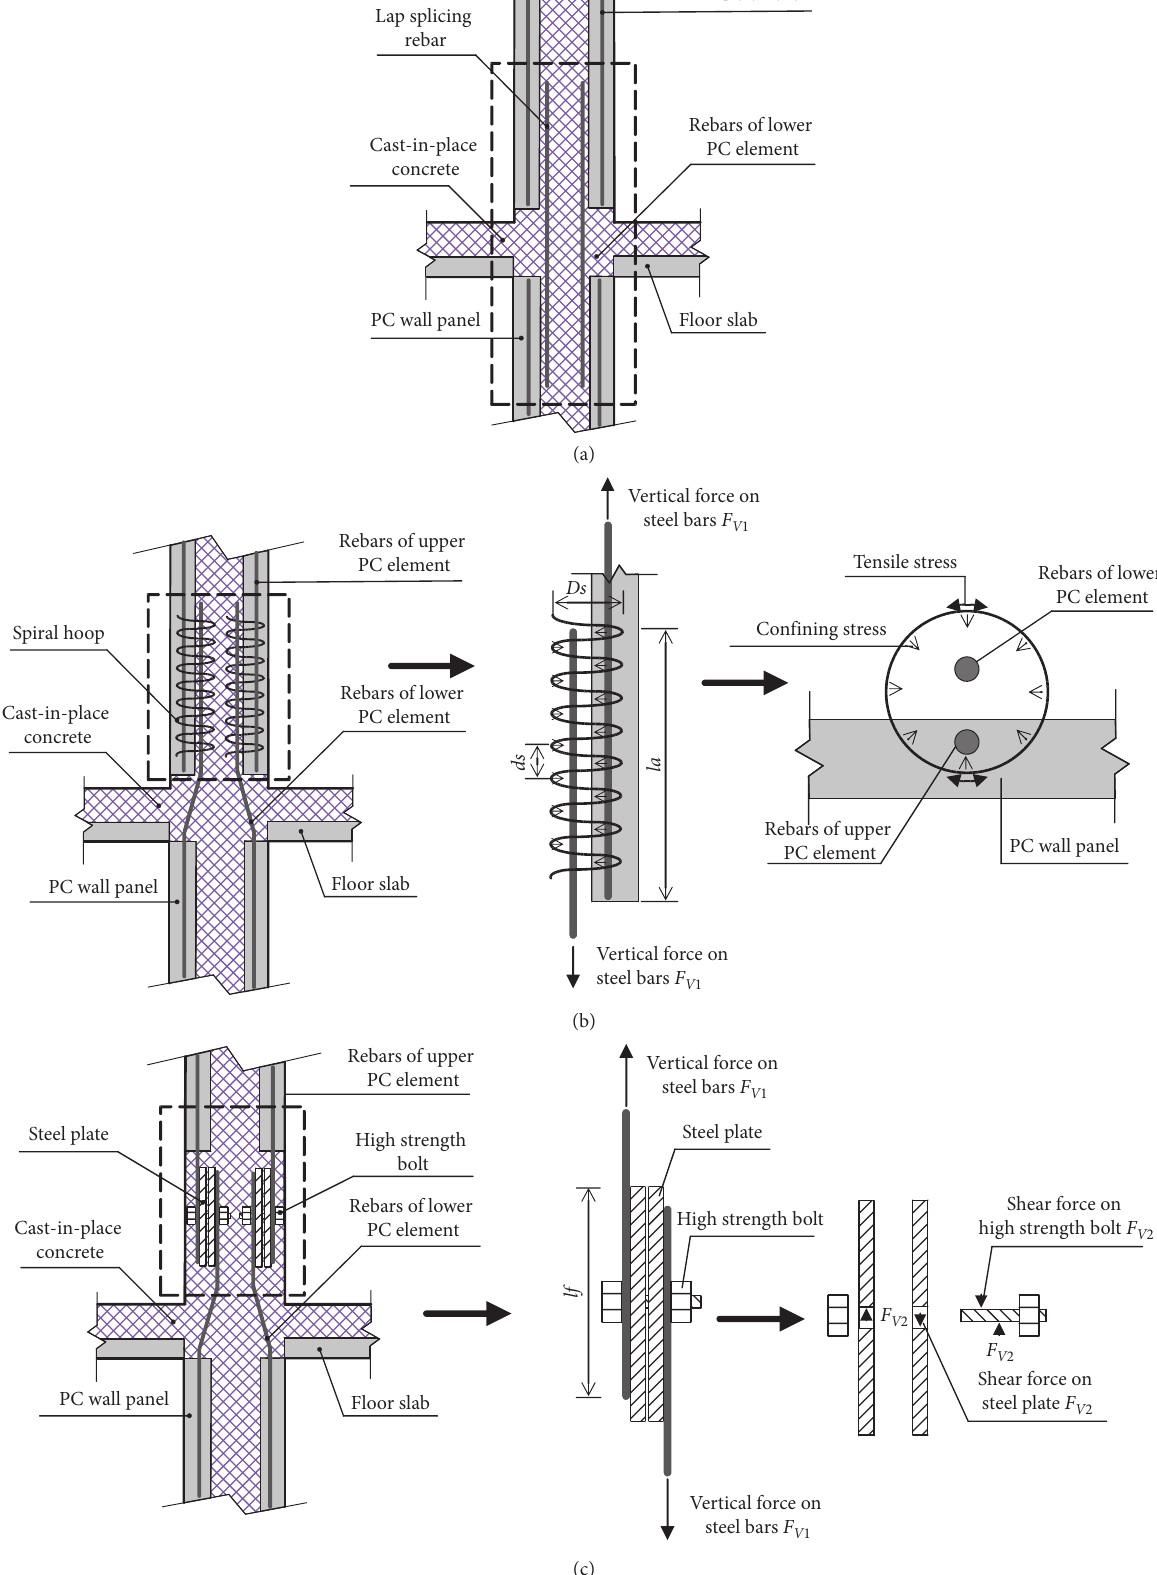
Figure 1: Schematic diagram of the connecting methods for SRCSW. (a) Lap splicing connector. (b) Spiral hoop connector. (c) Bolted steel